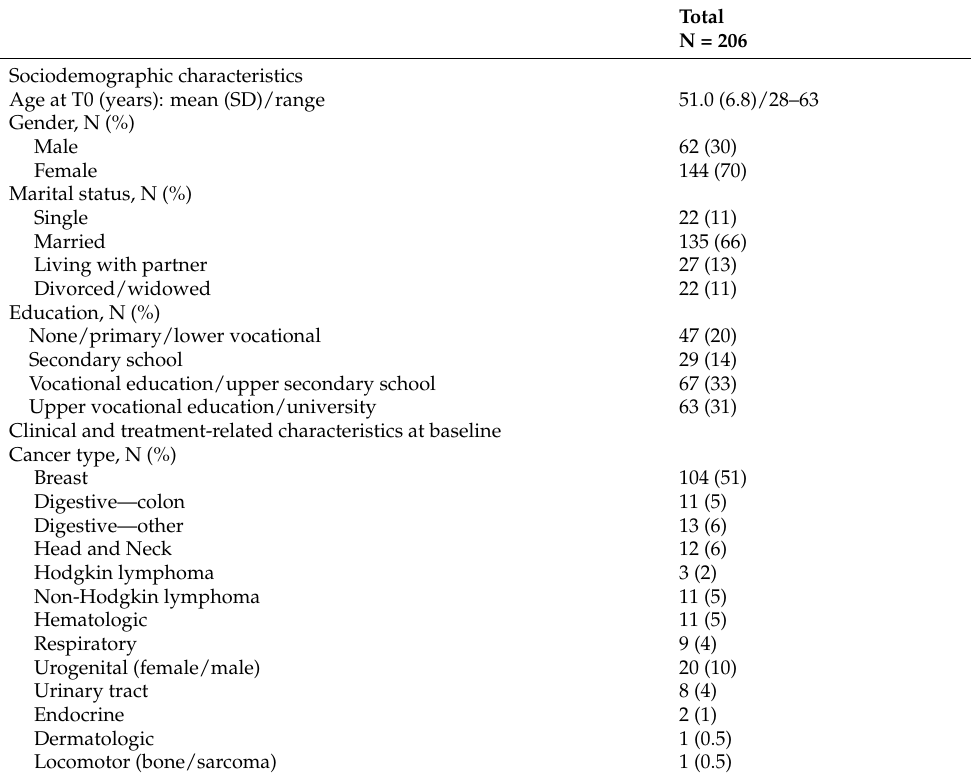
Table 1. Sociodemographic, clinical and treatment-related characteristics at